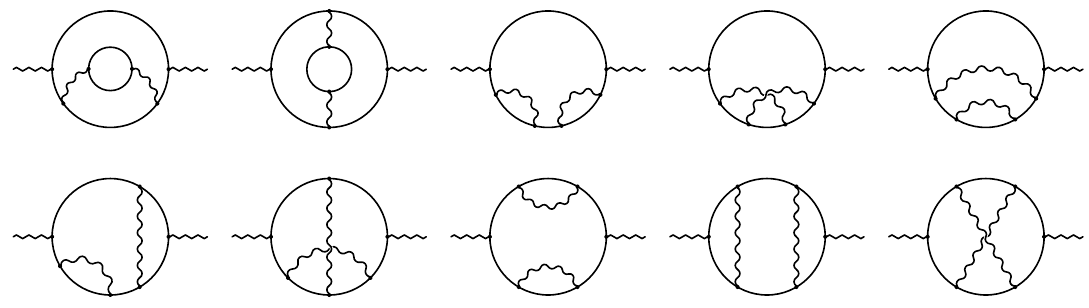
Figure 1 . Diagrams contributing to 3 -loop photon self energy in